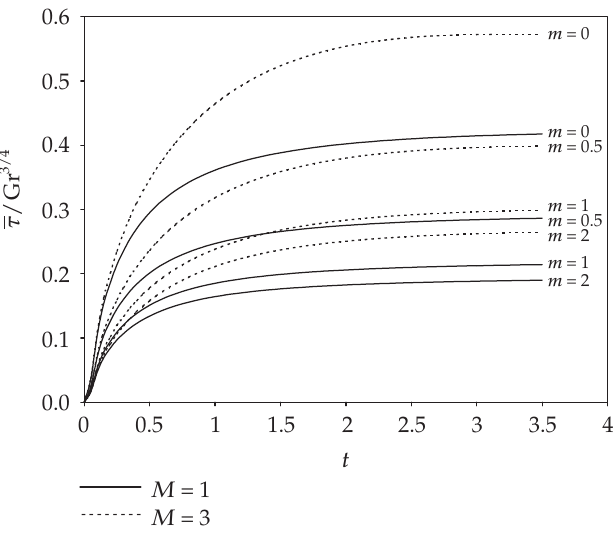
Figure 5.16 . The e ff ect of M and m parameters on average skin fric- tion at F = 0 . 01 and Pr = 0 . 7.